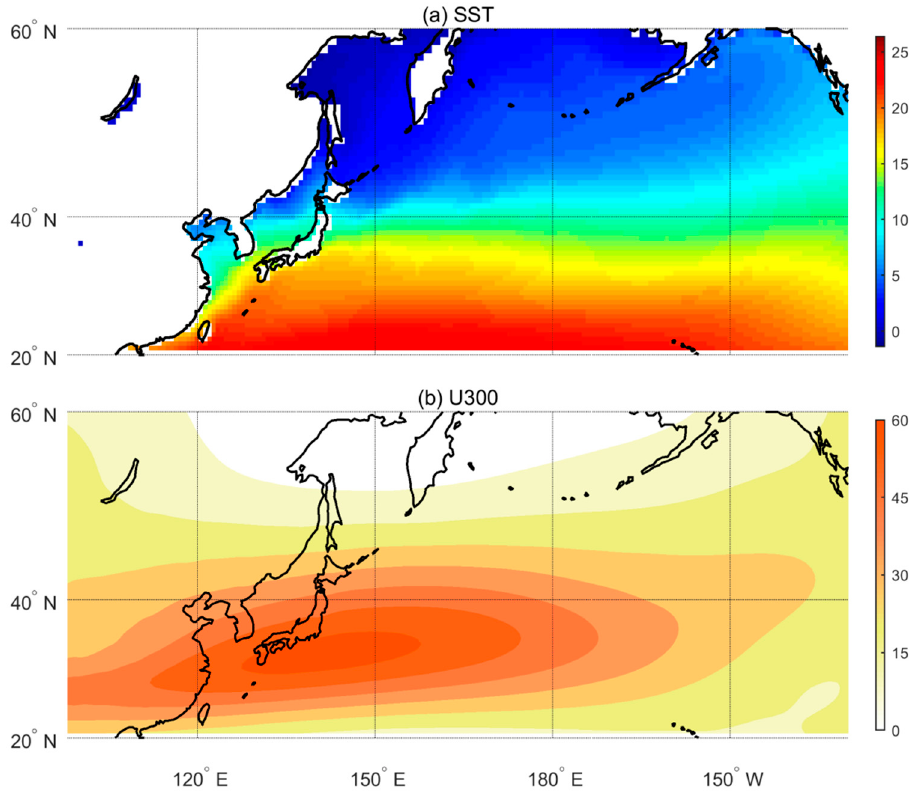
Figure 1. ( a ) Sea surface temperature distribution in winter, Unit: ° C; ( b ) climatological zonal wind at 300 hPa pressure level, Unit: m/s.